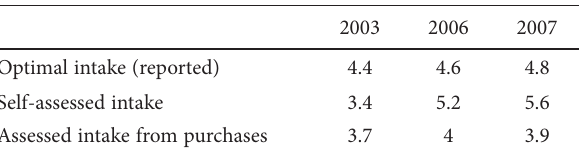
Table 2. Knowledge, self-assessed consumption purchases of fruit and vegetables in the UK, number of portions per person per day (years 2003, 2006, 2007).